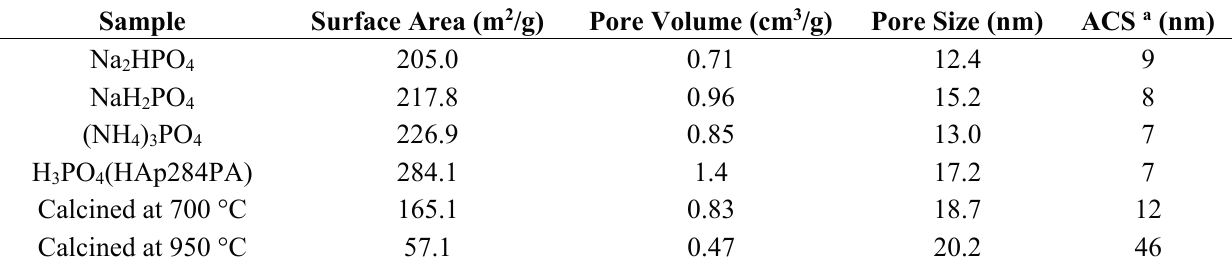
Table 1. Results of BET analysis of the produced HAP